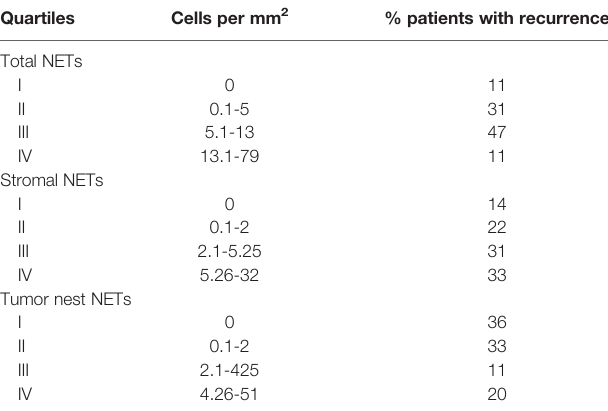
TABLE 4 | Mortality within 5 years of cervical cancer diagnosis strati fi ed by NET density quartile.